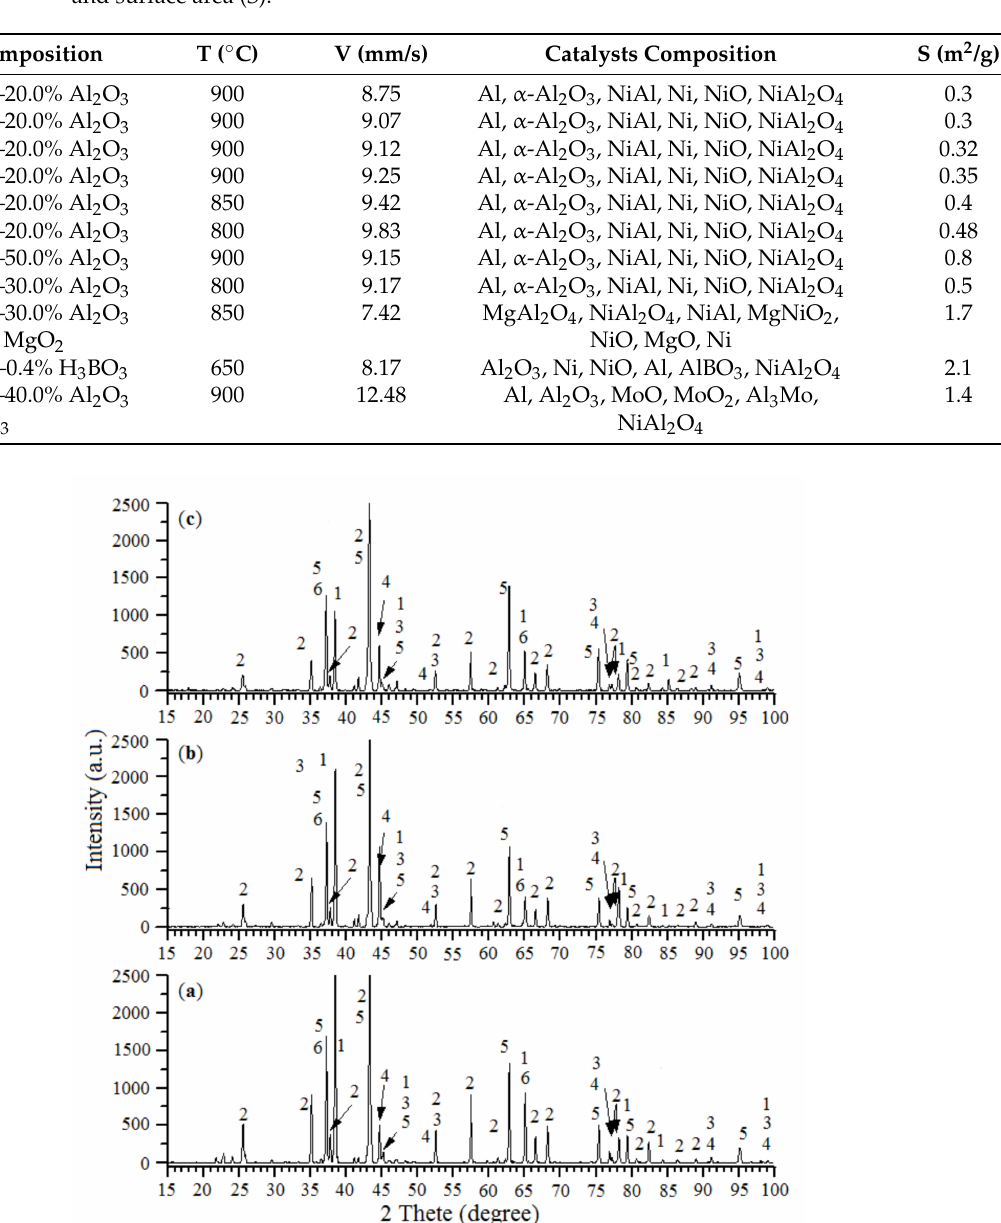
Figure 1. XRD analysis of the NiO–Al–Al 2 O 3 catalysts with different contents of elements: ( a ) 29.2% NiO—50.8% Al—20.0% Al 2 O 3 , ( b ) 31.0% NiO—49.0% Al—20.0% Al 2 O 3 , ( c ) 34.4% NiO—45.6%